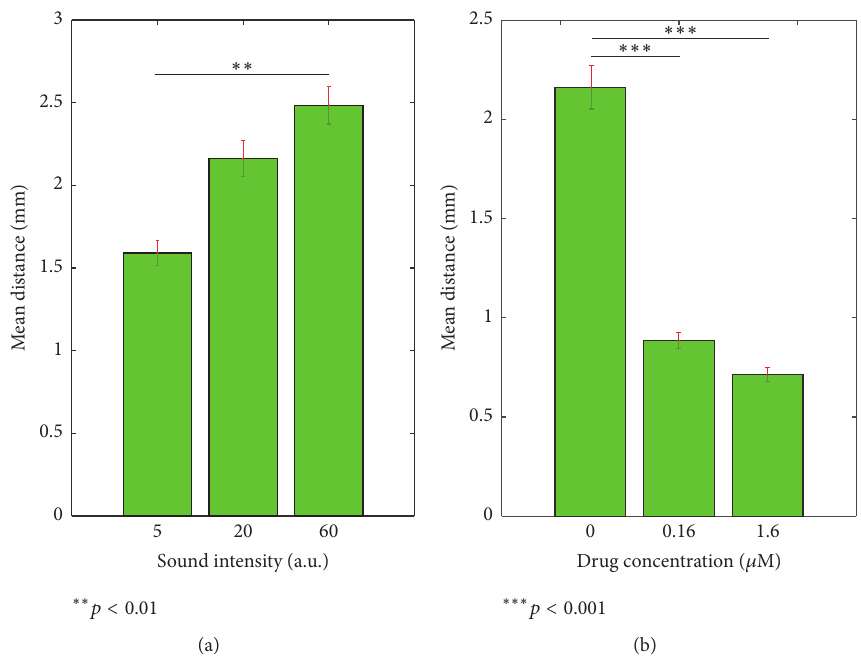
Figure 3: Characterizing the startle response. (a) Mean moving distance of larvae with 400Hz sound of intensity linearly grown from 5 to 60 with an arbitrary unit. This results in a sound level in about 20 dB. The values are 1.59±0.23 , 2.16±0.34 , and 2.48±0.35 . There is statistically significant difference between the 1st column and 3rd column ( 𝑝 < 0.01 ) but not between adjacent columns. (b) Mean moving distance as function of the neomycin concentration. The values are 2.16 ± 0.34 , 0.89 ± 0.12 , and 0.71 ± 0.11 . There is statistically significant difference between the 1st column and 2nd column ( 𝑝 < 0.001 ) but not between 2nd and 3rd columns ( 𝑝 = 0.09 ). The error bar is standard